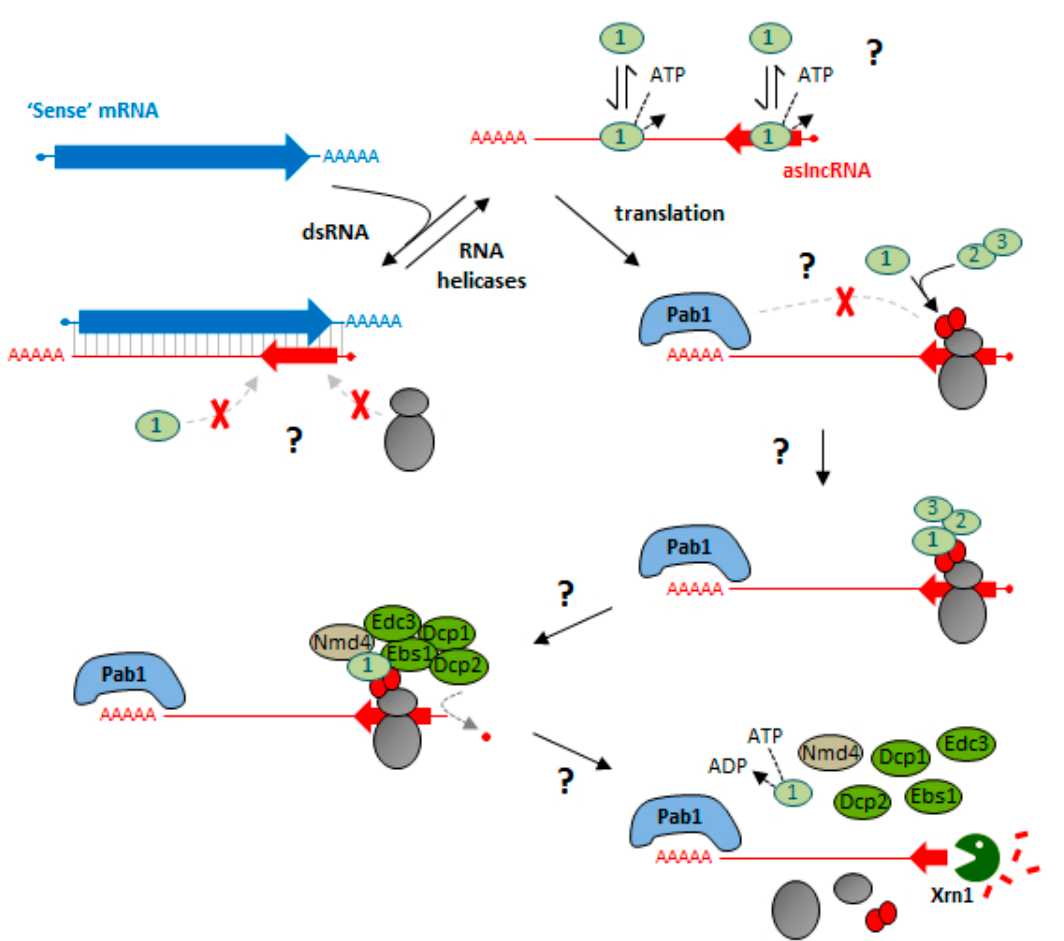
Figure 3. Model of yeast cytoplasmic aslncRNA degradation by NMD. Once in the cytoplasm, an aslncRNA (red) would rapidly be bound by ribosomes, unless in a dsRNA structure with its paired-sense mRNA (blue). This dsRNA might also interfere with Upf1 binding to the aslncRNAs and could be removed by the action of RNA helicases. The detection of a long 3 ′ UTR would trigger NMD by a mechanism similar to the “faux 3 ′ UTR”. A Upf1-23 complex would form at the level of the termination codon thanks to the interaction between Upf1 and eRF1/eRF3. The subsequent formation of the Upf1-decapping complex would lead to the decapping of the aslncRNA by Dcp2. Upon ATP-dependent disassembly of the complex, the decapped aslncRNA is degraded by Xrn1. The mRNA and the aslncRNA are represented in blue and red, respectively. Large arrows and thin lines represent the coding regions and the UTRs, respectively. The ribosome and NMD/decapping factors are represented as in Figure 1.